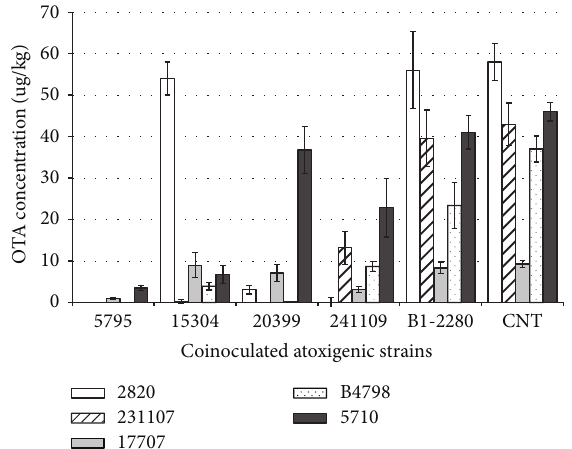
Figure 1: Screening of OTA − strains efficacy in containing toxin accumulation by OTA+ strains. Toxigenic strains (2820, 231107, 17707, B4798, and 5710) were coinoculated in synthetic medium with atoxigenic strains (5795, 15304, 20399, 241109, and B1-2280); cultures of OTA+ strains grown singularly represented the toxin accumulation control (CNT). Data are the mean values obtained from three independent experiments. Error bars represent standard